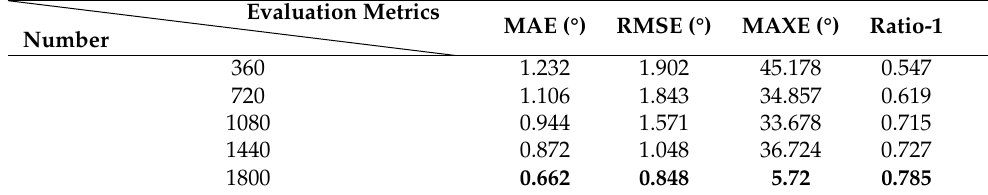
Table 5. Test results of using different numbers of actual